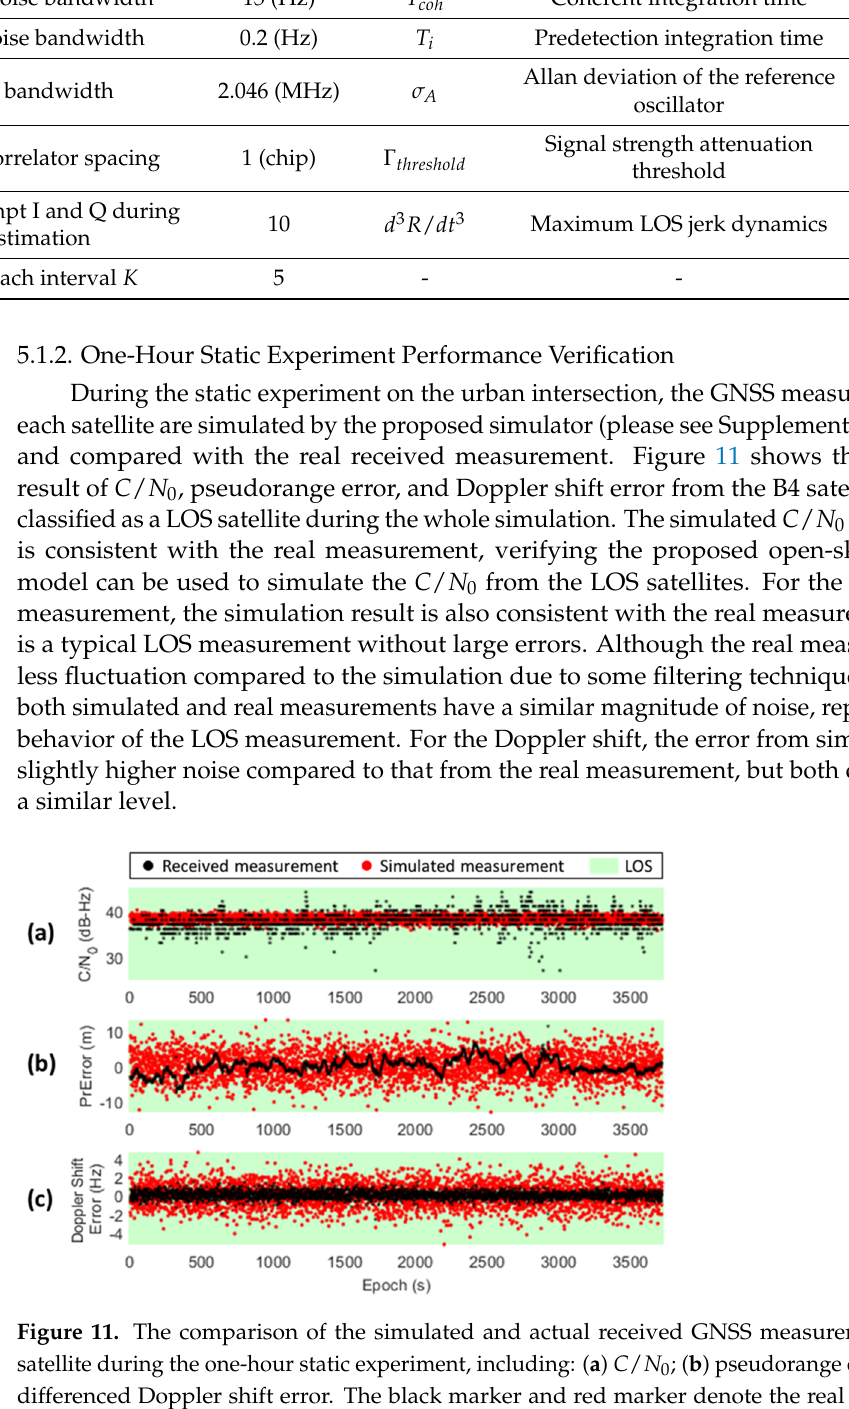
Table 3. The value of receiver-related parameters during simulation.